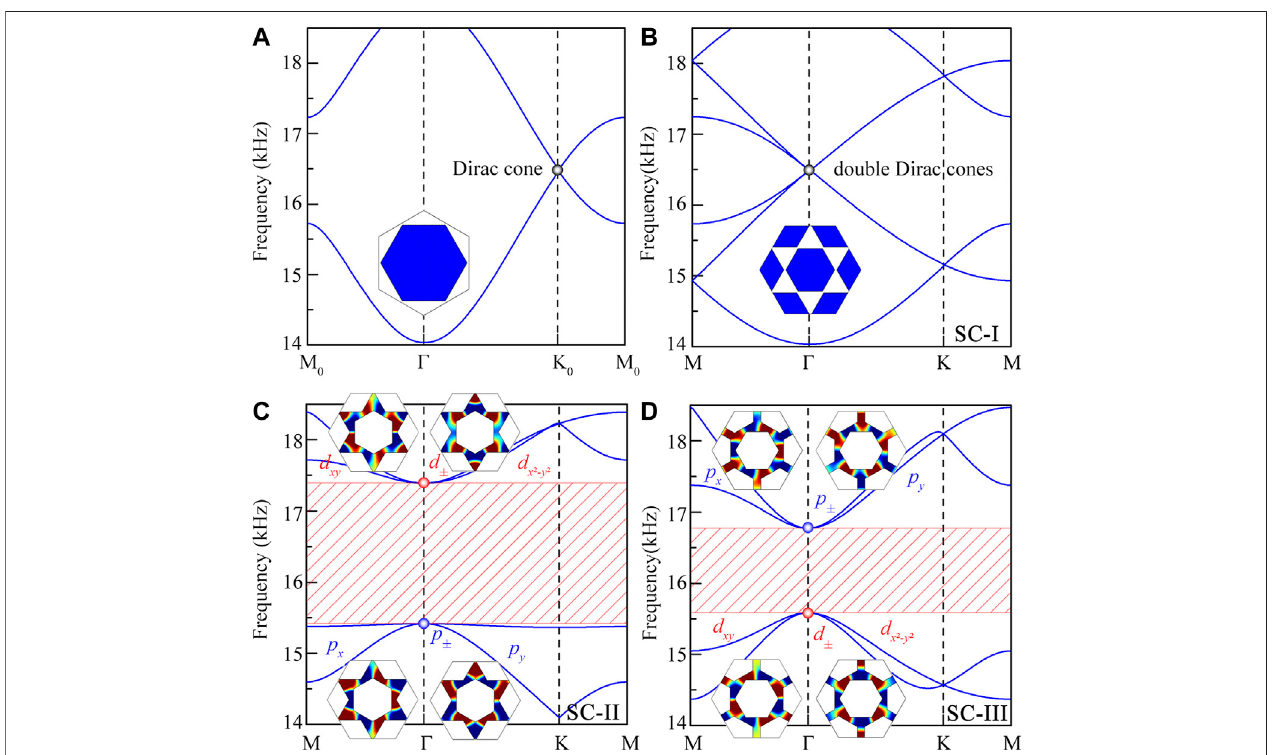
FIGURE2| Dispersionrelationsoftheunits (A) Aand (B) BintheSC-I ( θ 0 (cid:1) 0 o and θ (cid:1) 0 o ),andoftheunitBinthe (C) SC-II( θ 0 (cid:1) 30 o and θ (cid:1) 0 o )and (D) SC-III ( θ 0 (cid:1) 0 o and θ (cid:1) 30 o ). Black dots in Figures 2A,B represent the Dirac points. Eight insets in Figures 2C,D are the simulated pressure eigenfunctions of the pseudospin dipolar ( p x and p y ) and quadrupolar modes ( d xy and d x 2 − y 2 ) at the BZ center (red and blue dots) of the SC-II and SC-III, respectively.